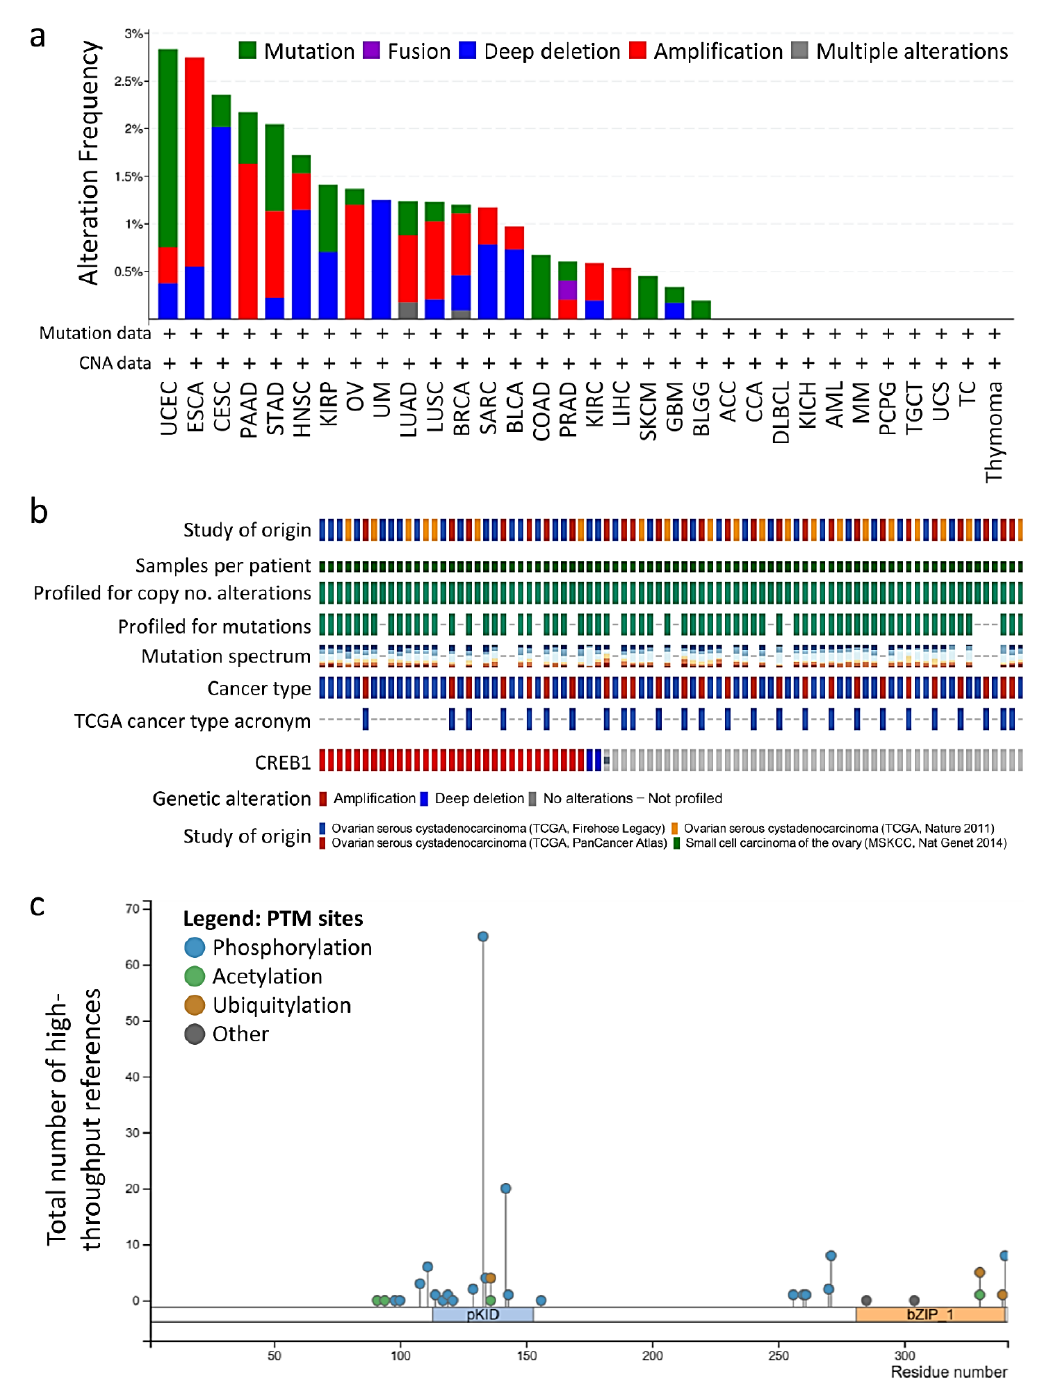
Figure 2. Copy number amplification of CREB1 gene in OV. ( a ) CREB1 gene was analyzed for gene alterations (mutation status and copy number variation) in various cancer types using “TCGA, PanCancer Atlas” data in the cBioPortal cancer genomics database; ( b ) Oncoprint table of significant signature genes. The Oncoprint table summarizes genomic alterations in all queried genes across samples. Red bars indicate gene amplifications, blue bars are homozygous deletions, and green squares are nonsynonymous mutations. ( c ) A cartoon diagram for the gene and protein structures of CREB1. This figure was adapted from the image obtained from the cBioPortal website.